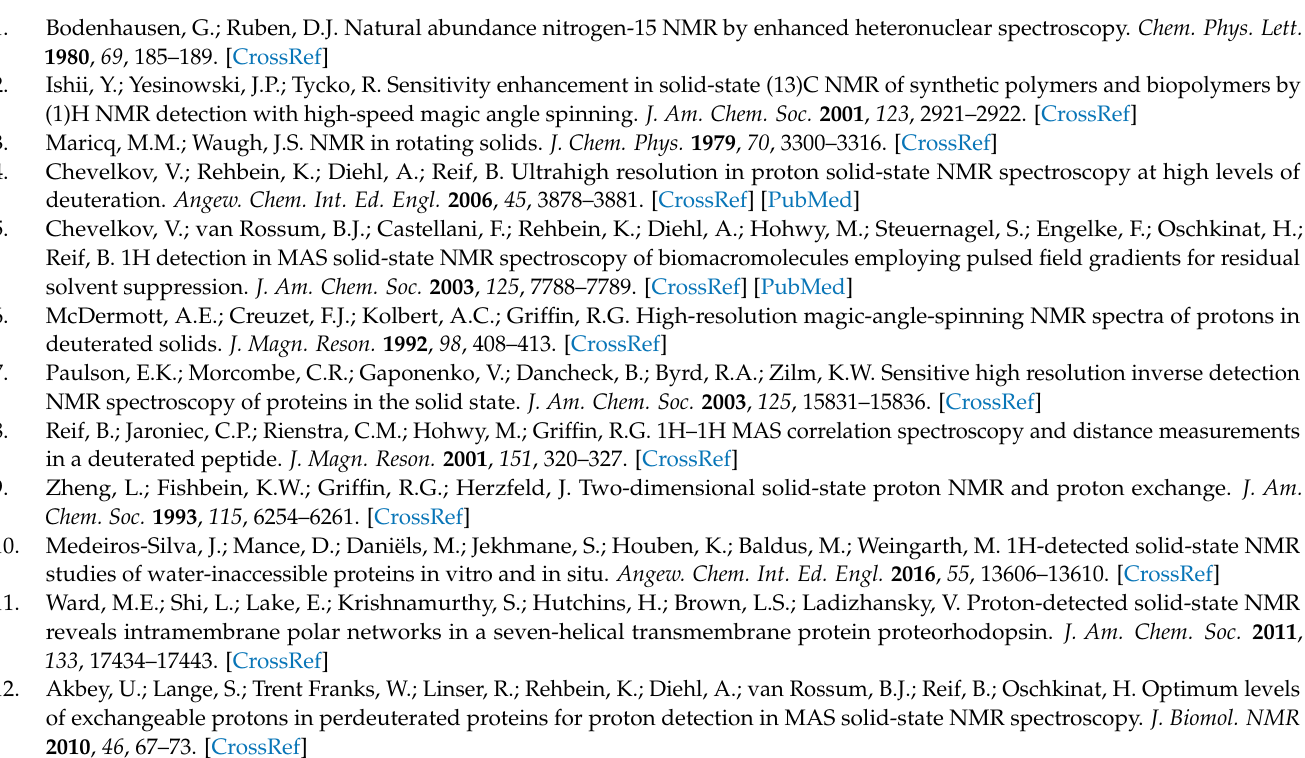
angle setting methods, Figure S5: The structural representation of 16 spins of Table S3 that were en- tered in linewidth simulations, Figure S6: The water position in the calculation, Table S1: Acquisition parameters of the (H)CH and (H)NH spectra at the 950 MHz spectrometer, Table S2: Acquisition parameters of the (H)CH and (H)NH spectra at the 1200 MHz spectrometer Table S3: The set of spins used in the linewidth simulations, Table S4: Comparison of experimental and DFT-derived chemical